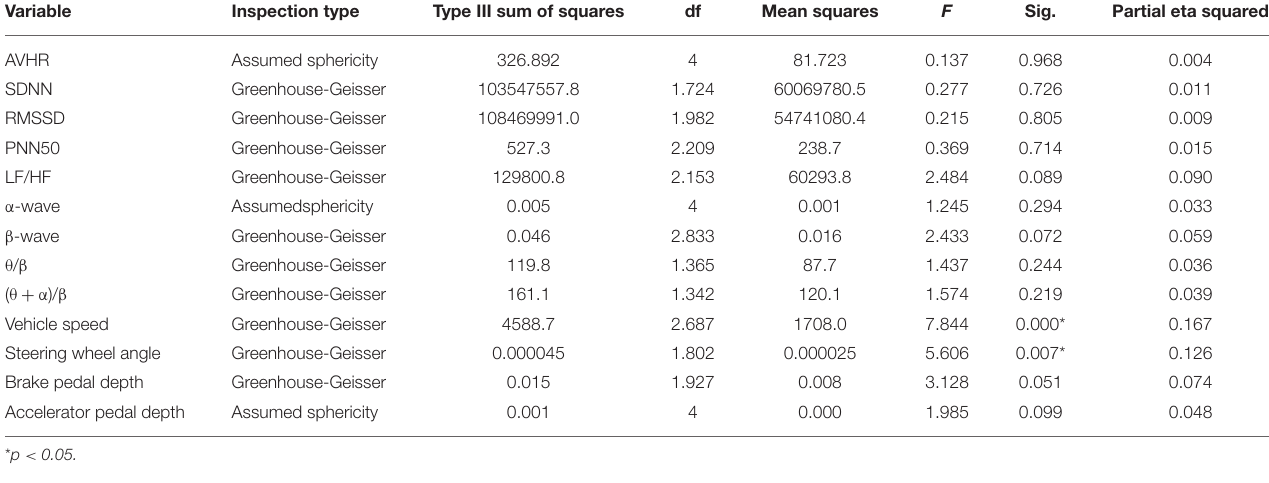
TABLE 4 | Test results of within-subject effects on HRV, EEG, and vehicle behavior indicators for different sound scenarios. Variable